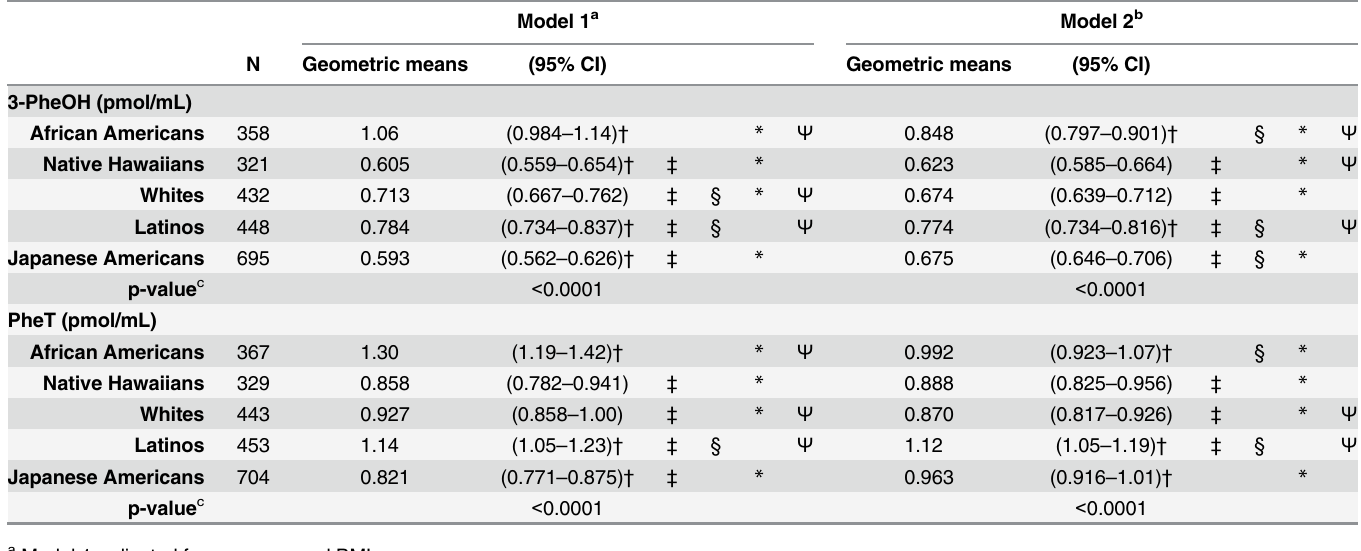
Table 4. Geometric means of 3-PheOH and